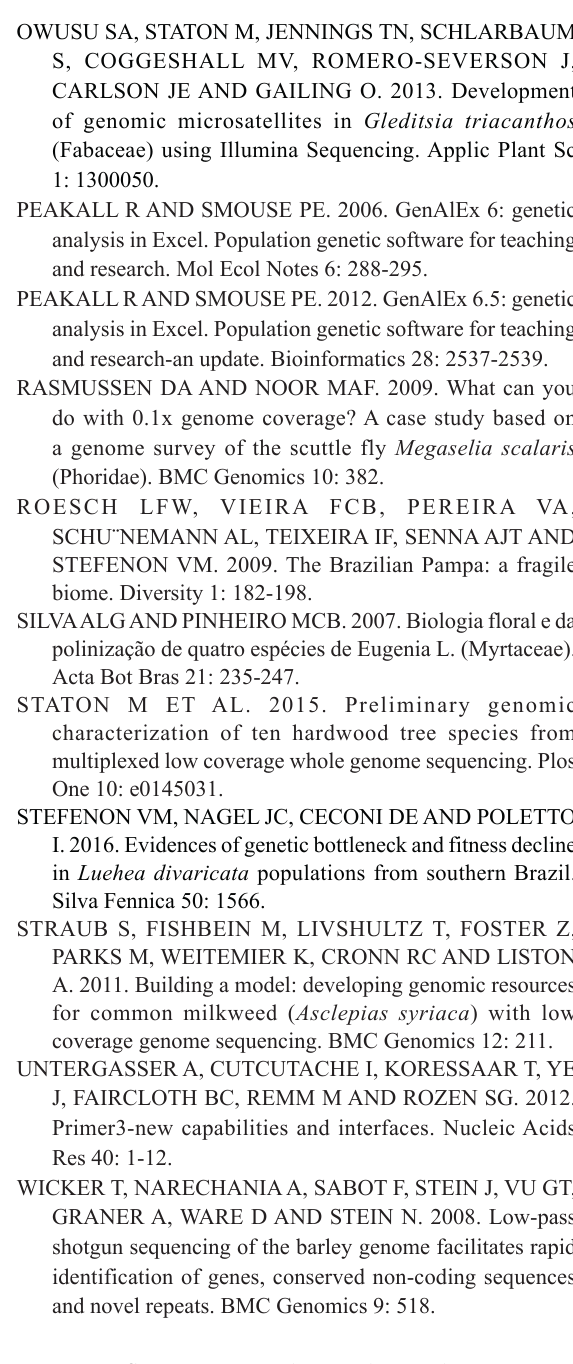
Table SI - List of SSR loci discovered for Eugenia uniflora using low coverage sequencing strategy and selected after in silico amplification. Sequencing was performed using an Ion PGM® platform. Table includes primers sequence (forward and reverse), repeat motif, and genBank accession number (genBank